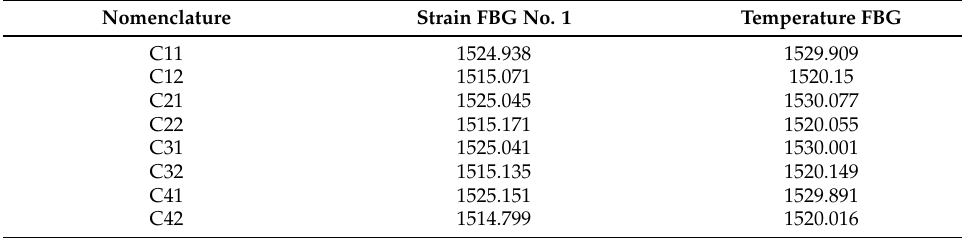
Table 1. Column sensor wavelengths (nm).